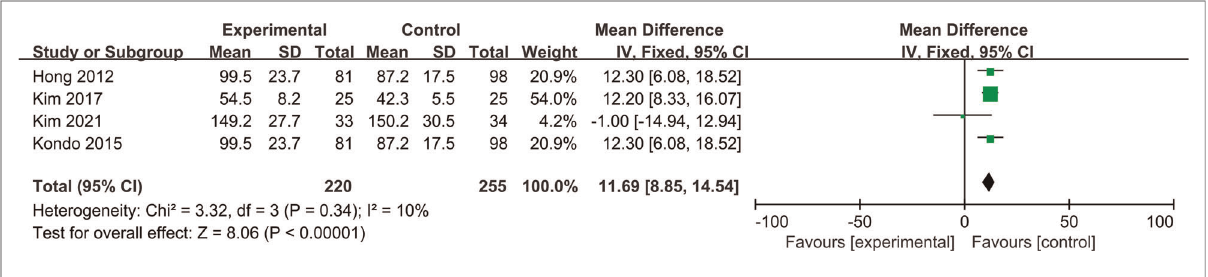
FIGURE 11 Forest pot for operation time.